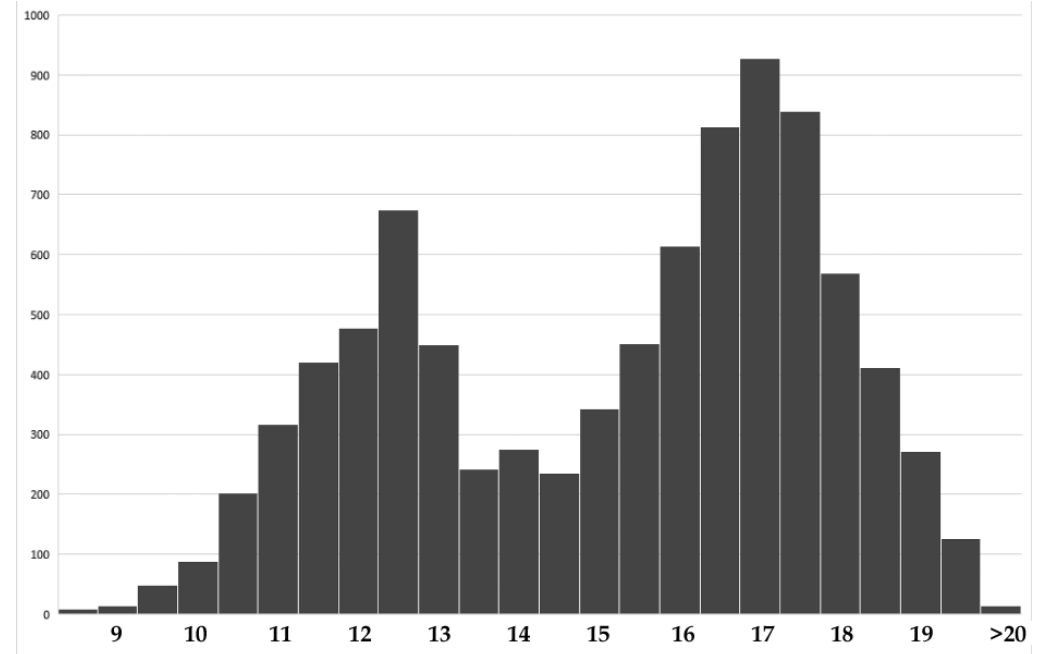
Figure 7. Distribution of objects in the ISON database by the average reduced brightness (vertical axis – number of objects, horizontal – brightness in